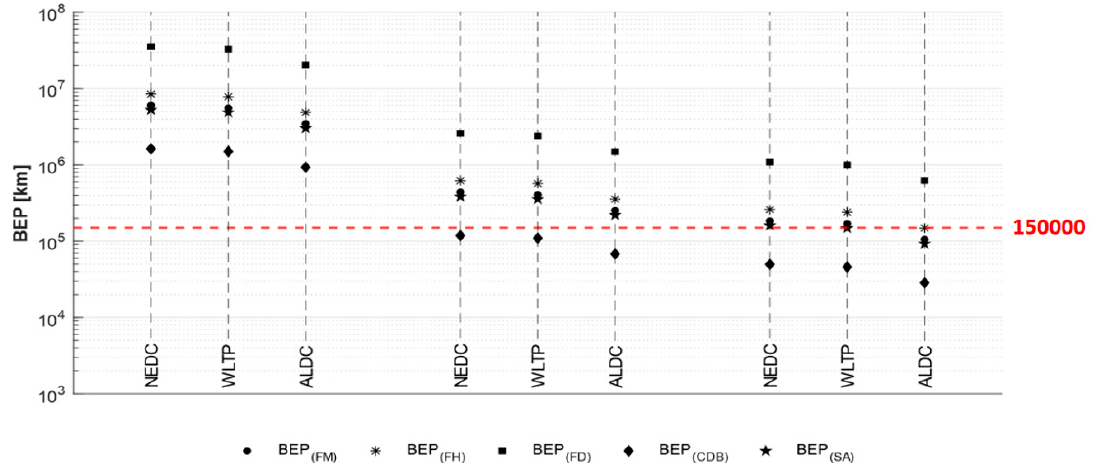
Figure 9. Break-Even Point (BEP) for sustainability case studies (Front Module (FM), Front Hood (FH), Front Door (FD), Crash Dashboard Beam (CDB), and Suspension Arm (SA)).